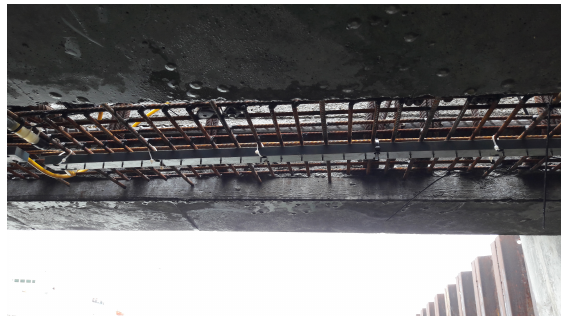
Figure 5. View of reinforcement bars and resistivity sensors for on-site measurement (bottom view).